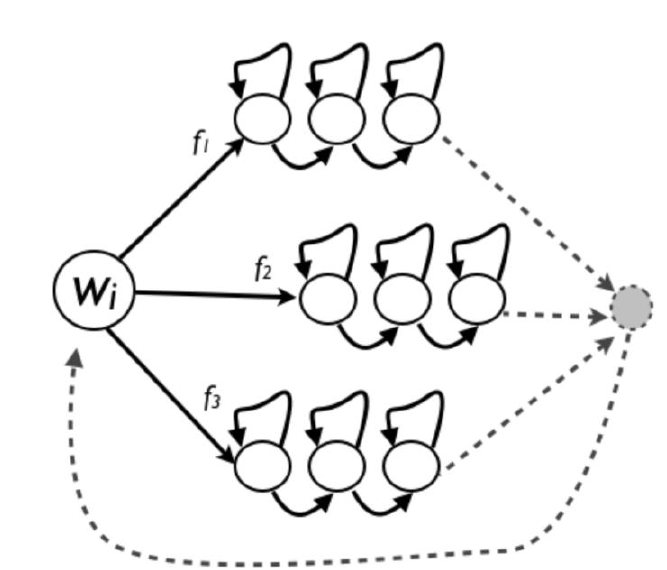
Figure 13. Multiple hidden Markov models combined into a joined model by connecting the end states to each start